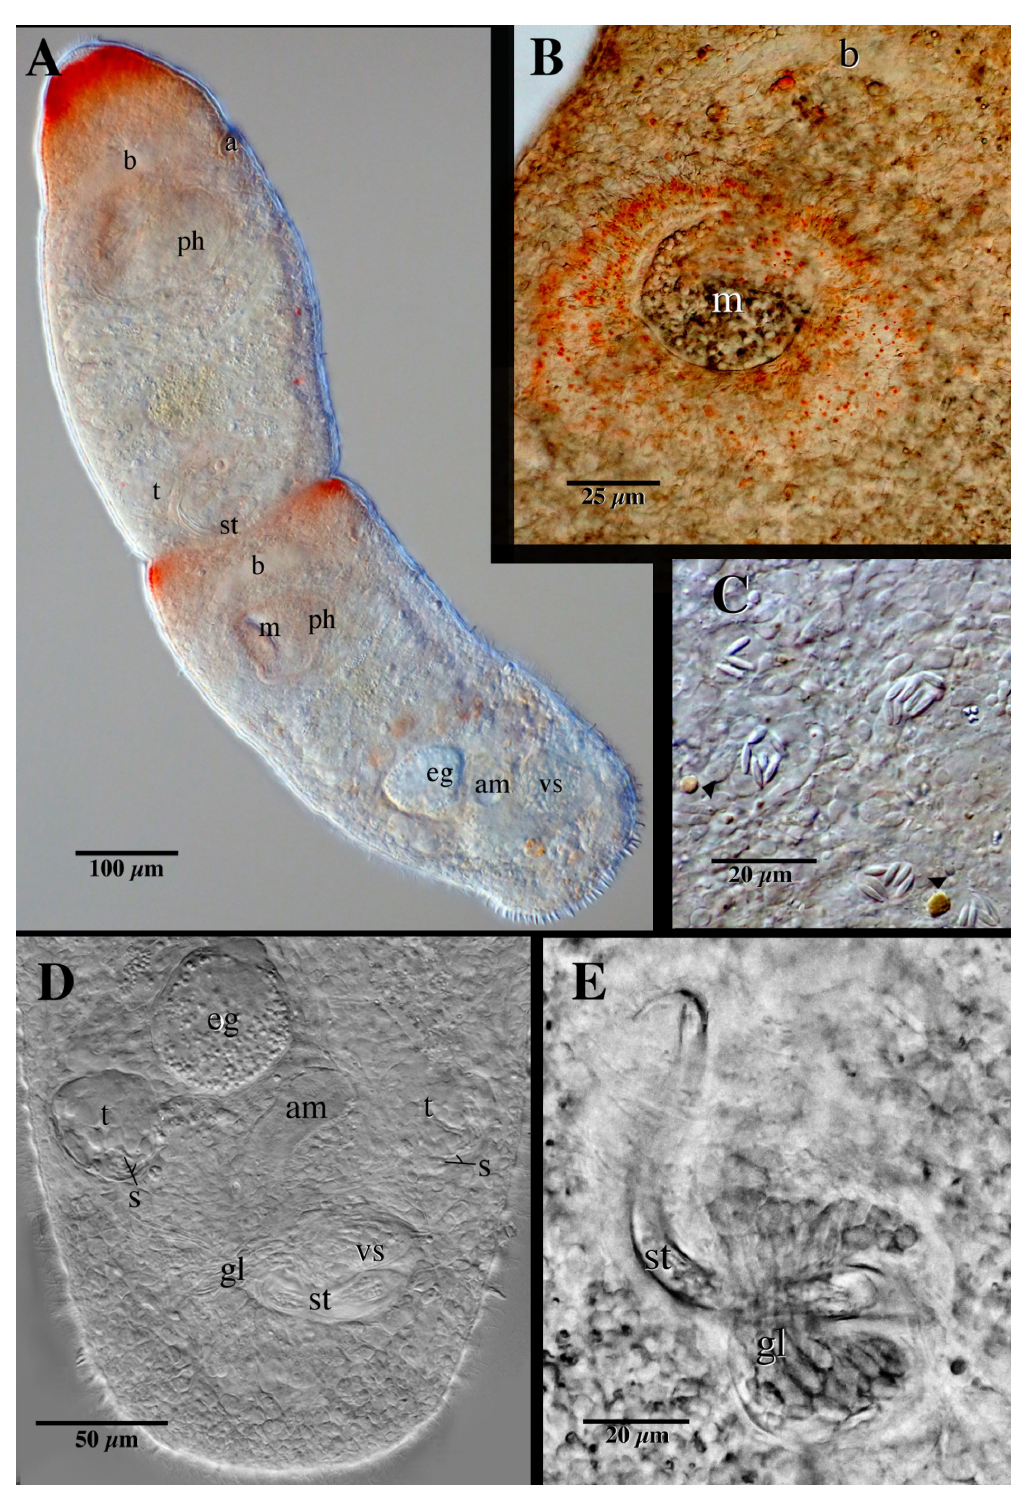
Fig. 4 . Microstomum rubromaculatum von Graff, 1882 . A . Entire body. B . Anterior end with focus on glands around mouth. C . Nematocysts. D . Posterior end with focus on reproductive anatomy. E . Male stylet. Abbreviations: a = auricles (ciliary pits); am = antrum masculinum; b = brain; gl = glands; i = intestine; m = mouth; o = ovary; ph = pharynx; s = sperm; st = male stylet; t = testis; vs = vesicula seminalis. Arrowheads indicate orange